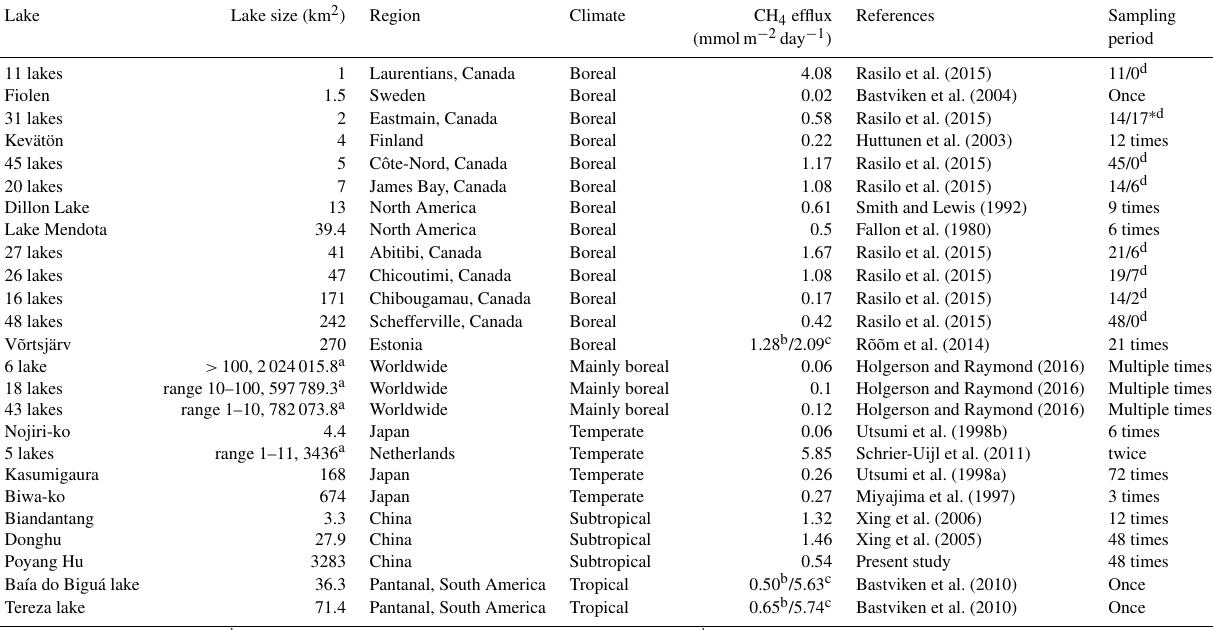
Table 4. Mean CH 4 effluxes in Poyang Hu in comparison with other large lakes.